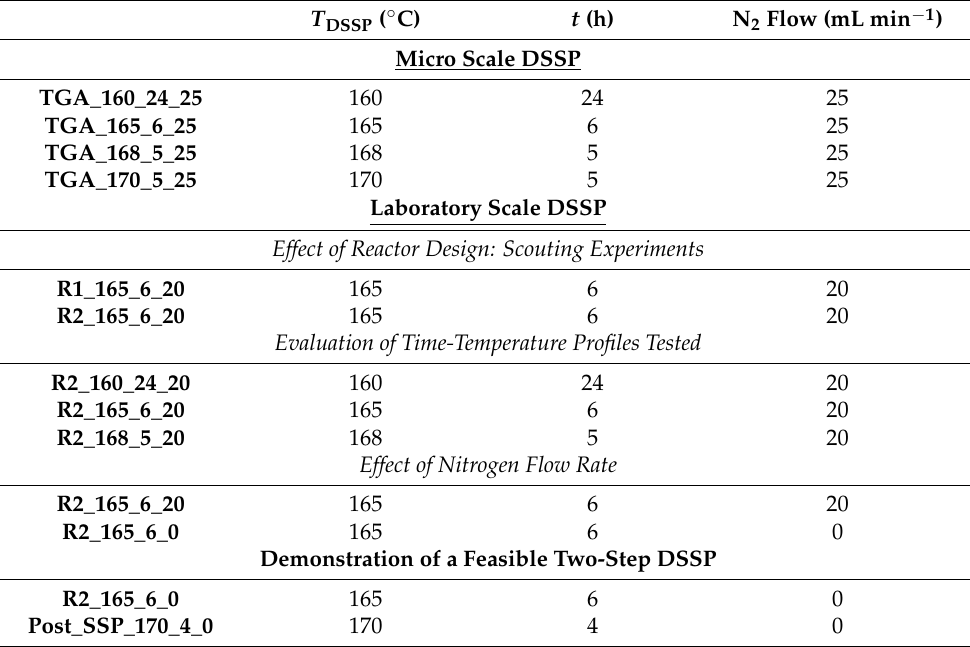
Table 1. DSSP reaction conditions and nomenclature for all